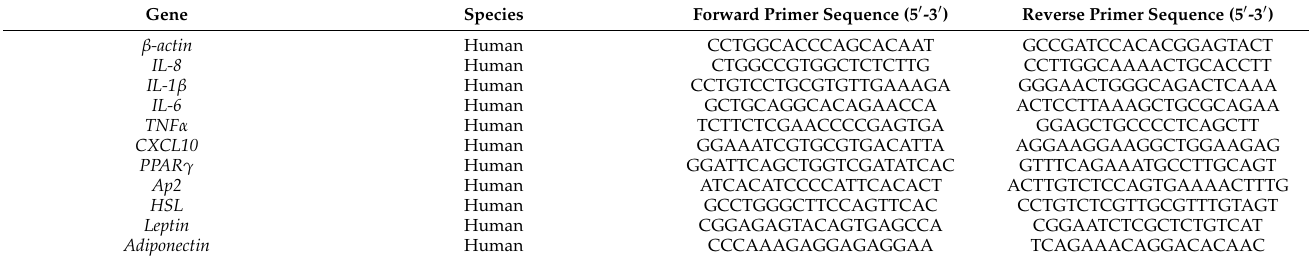
Table 1. PCR primer